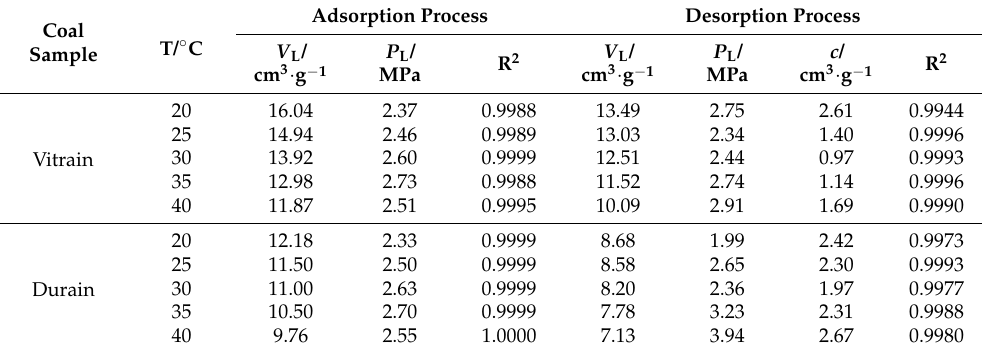
Table 6. Fitting results of the methane adsorption/desorption of vitrain and